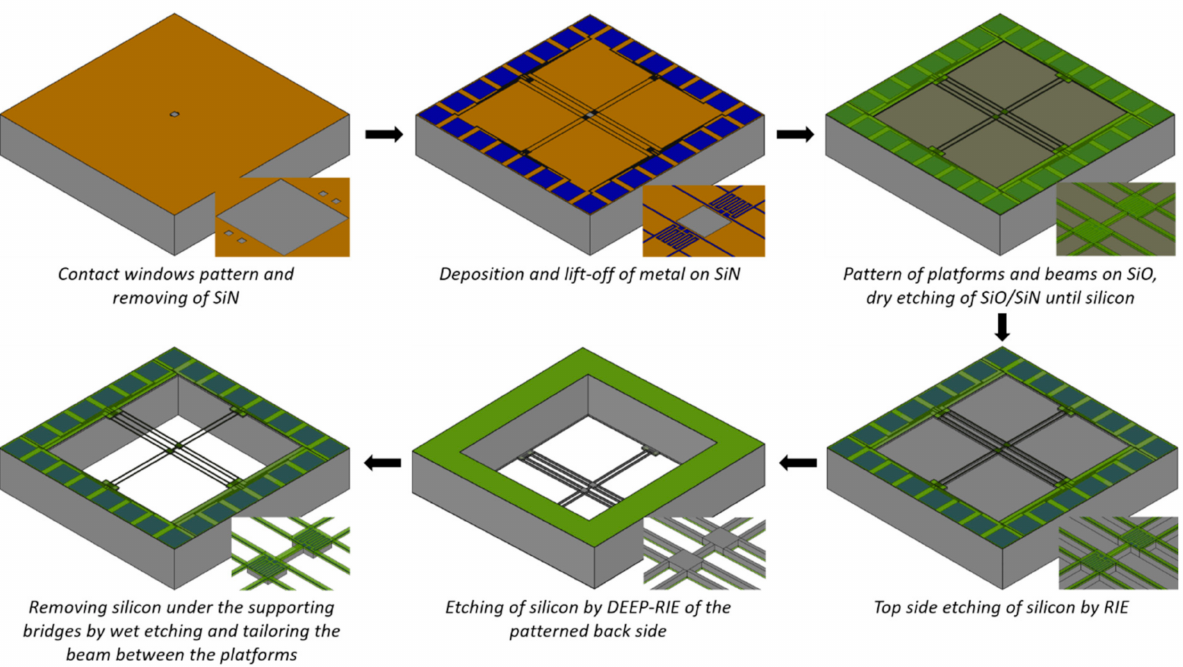
Figure 2. Schematic of a fabrication sequence for the microdevice with suspended platforms and